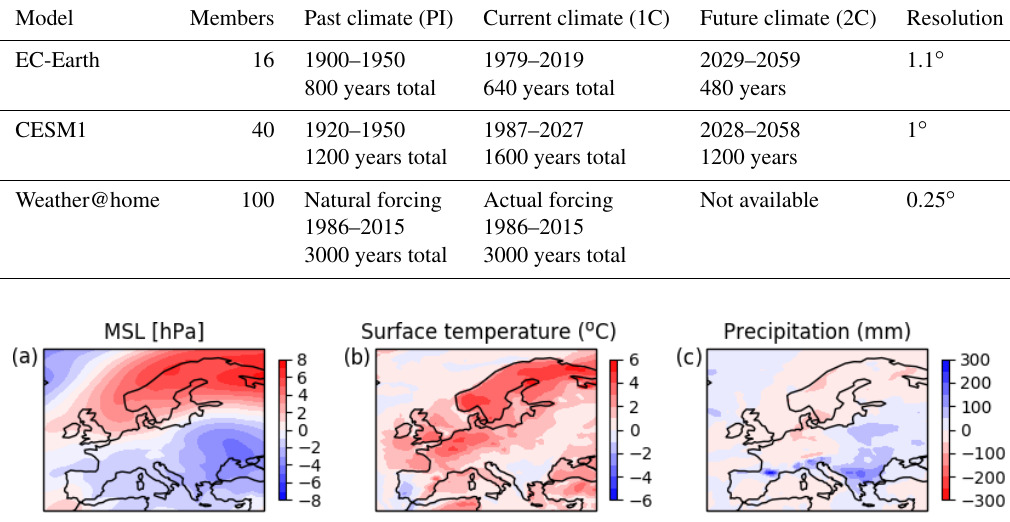
Figure 2. ERA-Interim July average anomalies of (a) mean sea level pressure (MSL), (b) surface temperature and (c) precipitation. Anoma- lies are constructed relative to 1981–2010 climatology.